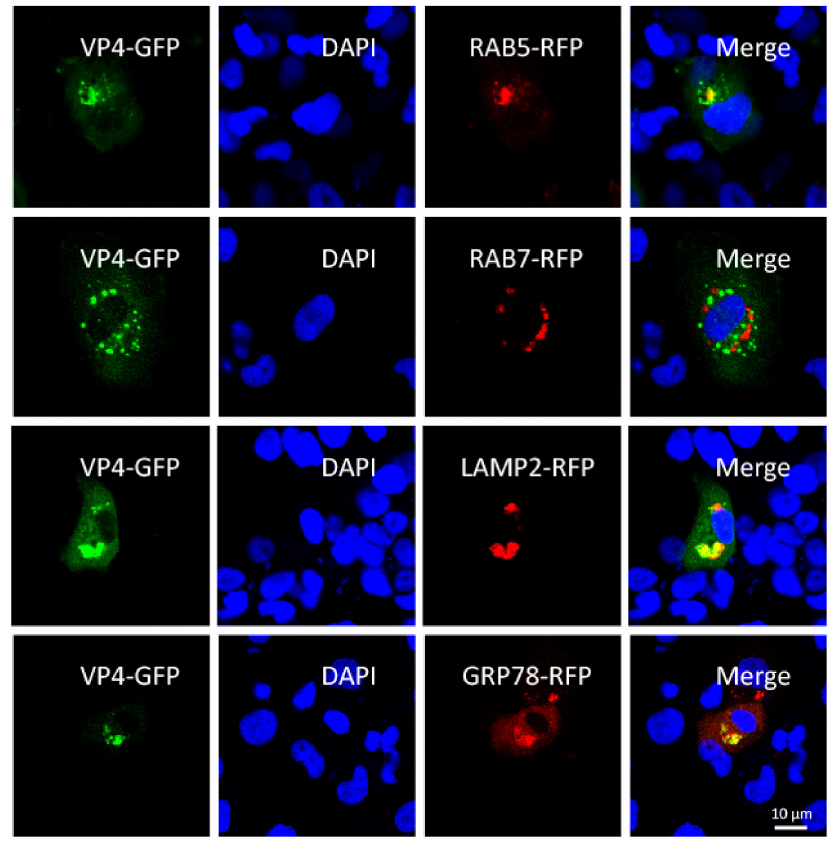
Figure 1. VP4 localizes to early endosome, lysosome, and endoplasmic reticulum (ER), but not late endosome. FHM cells were respectively transiently co-transfected with VP4-eGFP and LAMP2, a lysosome protein marker, VP4-eGFP and RAB5-RFP, an early endosome protein marker, VP4-eGFP and RAB7-RFP, a late endosome protein marker or VP4-eGFP and GRP78, an ER protein marker, and seeded on observation dishes for confocal microscope examination. After 48 h, the cells were fixed with 4% ( v / v ) paraformaldehyde and stained with DAPI. All samples were subsequently visualized using a confocal microscope. Green signals represent overexpressed VP4 and red signals stand for overexpressed LAMP2, RAB5, RAB7, or GRP78. The blue staining indicates nucleus. The yellow signals in the merged images indicate the co-localization between VP4 and organelle (original magnification × 40). All the experiments were repeated independently at least three